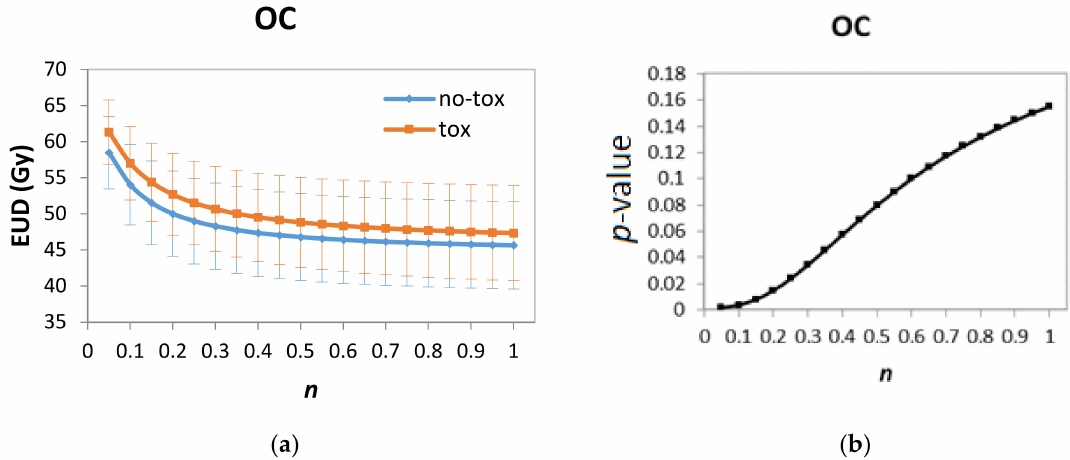
Figure A1. ( a ) Average Equivalent Uniform Dose (EUD) and standard deviations for oral cavity as a function of the volume parameter n used to calculate EUD. Results for patients with (red line, label “tox”) and without (blue line, label “no-tox”) where grade ≥ 2 acute salivary dysfunction is reported. ( b ) The p -values for the t -test comparing average EUDSs for patients with and without toxicity. The differences are statistically significant for n in the range 0.05–0.35.